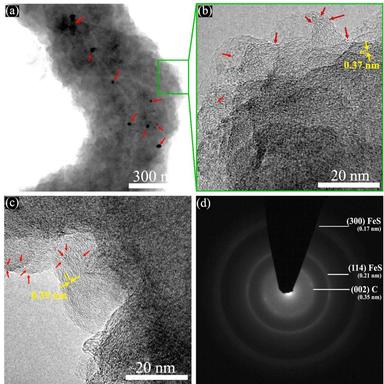
Cristina L. Rodríguez-Corvera et al. Transmission electron microscopy images TEM and HRTEM images of T1 = 180 ◦C. (a) Typical carbon fiber was found in the sample. (b-c) Close up to the carbon fiber surface showing carbon graphitic flakes with an interlayer distance of 0.39 nm for the carbon (002) crystallographic plane. (d) Electron diffraction pattern indexed to troilite crystal (FeS) using the crystallographic card 1009043. More SEM images showing the rugged carbon fiber surface can be seen in Fig. S2.